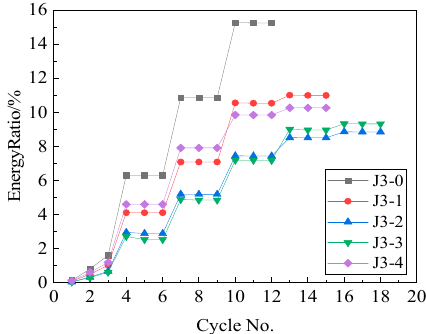
Figure 30. Energy dissipation ratio–cycle no. curves.